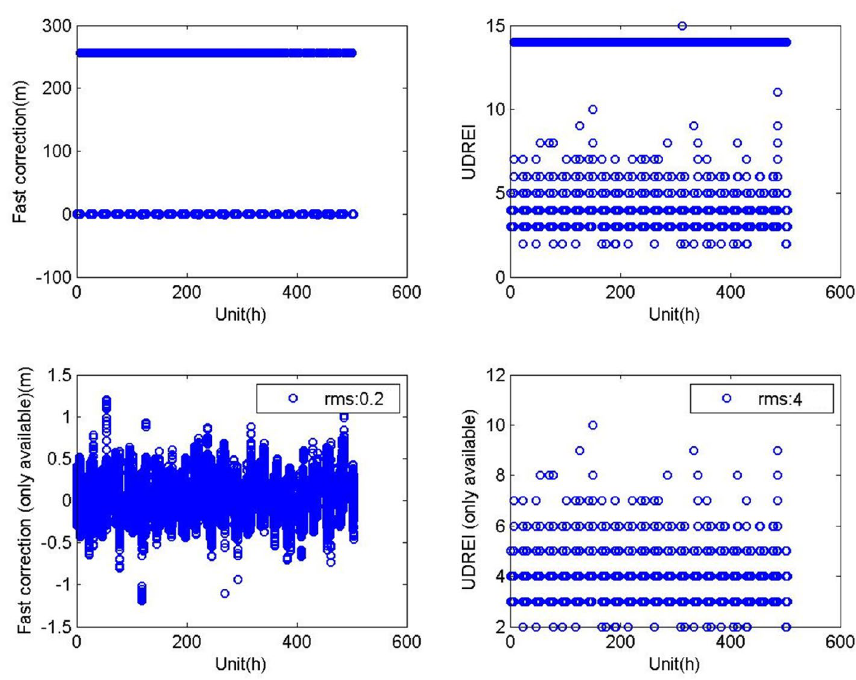
Figure 3. Fast correction and integrity information of the PRN20 satellite broadcasted from Dec 11 to 31, 2020 (top left: broadcasted fast correction parameters for 504 h; bottom left: available fat correction parameters; top right: broadcasted UDREI for 504 h; bottom right: available UDREI).